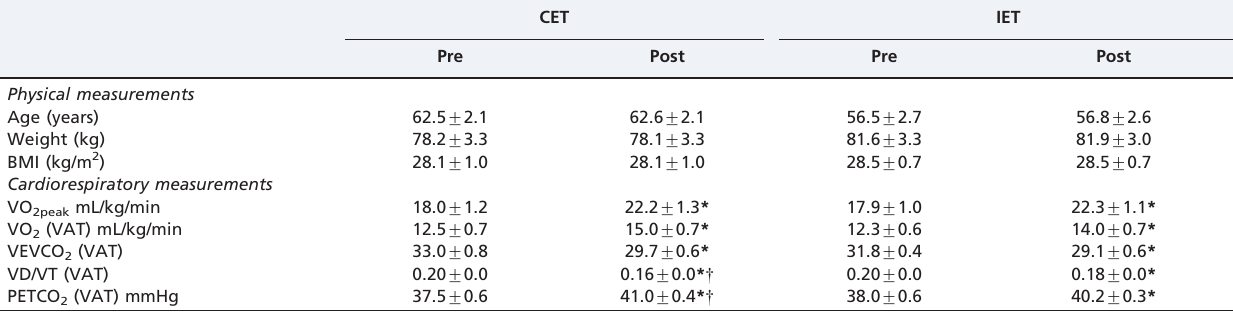
Table 2 - Physical and cardiorespiratory measurements in the CAD patients subjected to continuous exercise training and interval exercise training.